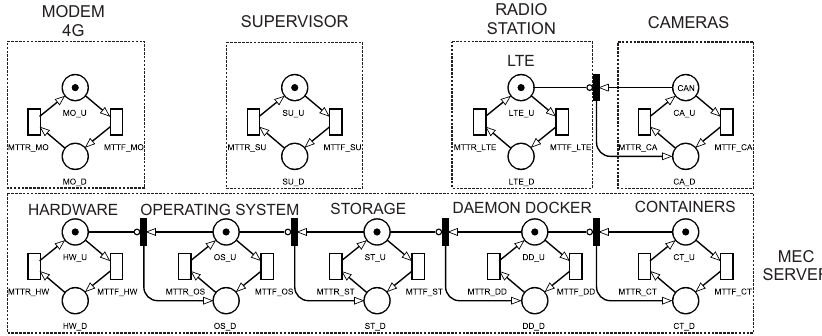
Figure 4. SPN model for surveillance architecture in smart